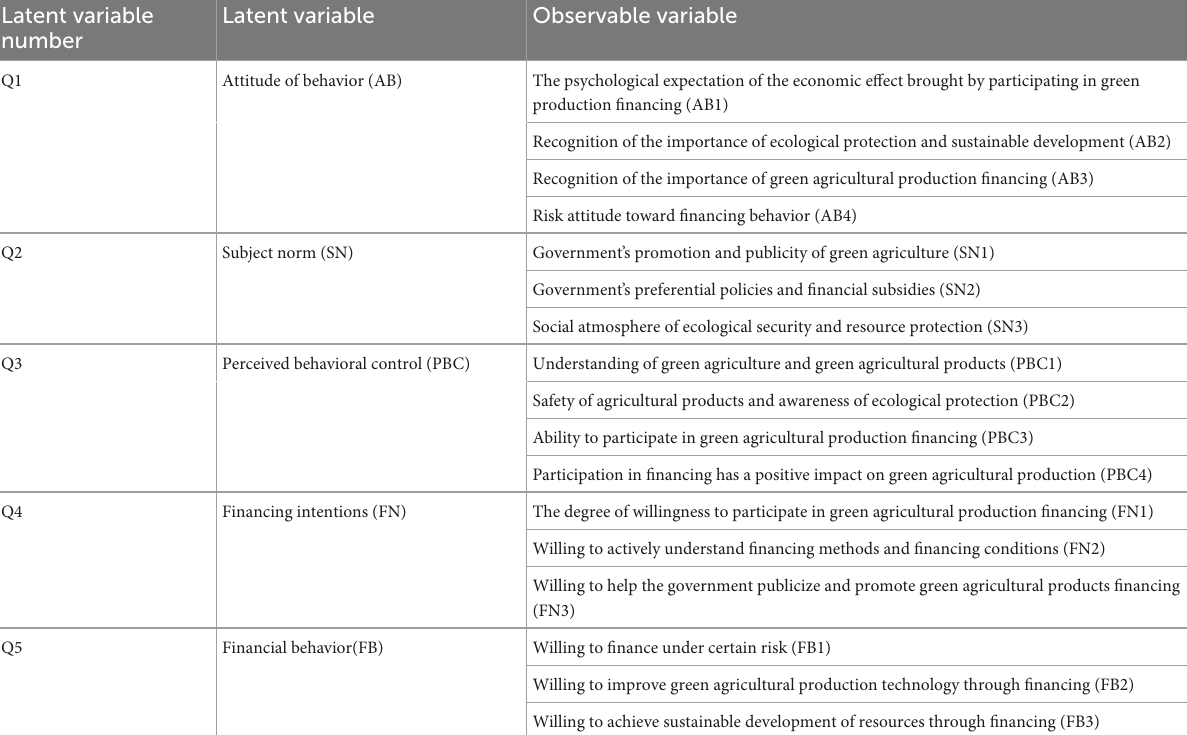
TABLE 2 Variables description and